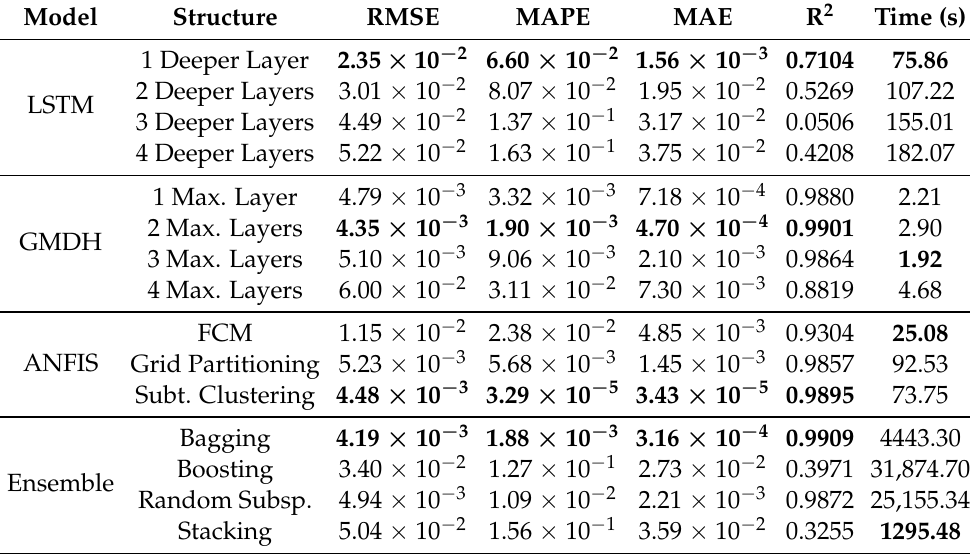
Table 1. Overall comparison of the models.